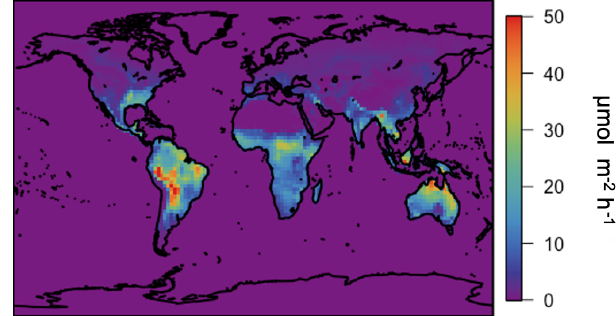
Figure 14. MEGAN3 isoprene emission factors (µgm − 2 h − 1 LAI − 1 ).